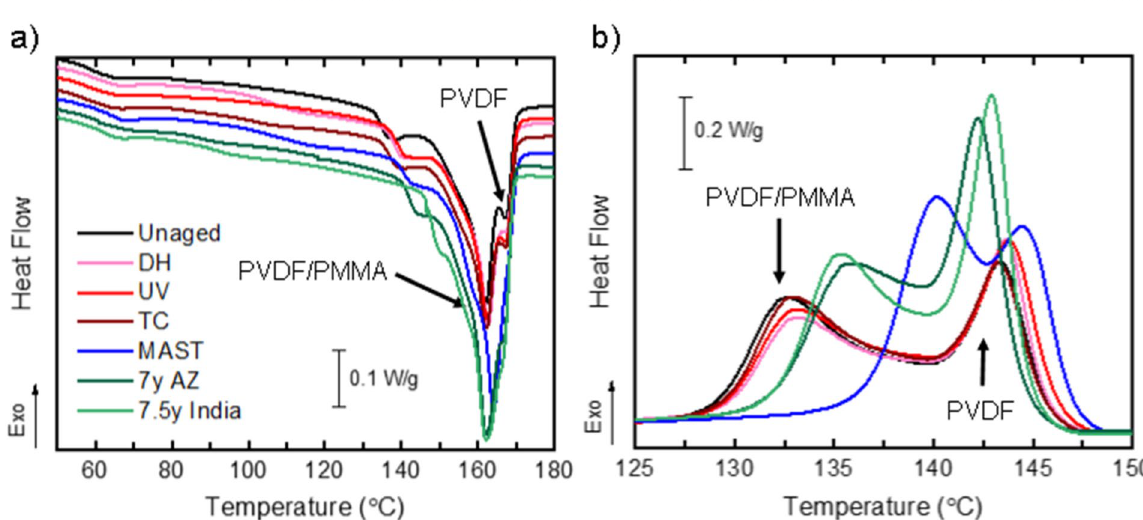
Figure 4. DSC thermograms of three-layer PVDF-B: ( a ) first heating and ( b ) cooling cycles comparing single (DH, UV, TC), sequential (MAST), and outdoor weathering with the unaged backsheet specimen. The arrows indicate the contributions of the distinct layers of PVDF-B. The curves are offset vertically in ( a ) to better distinguish the